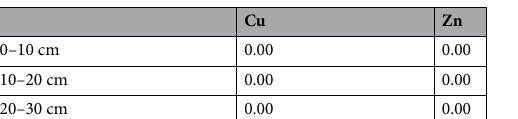
Table 2. Significance of the difference in the amount of Cu and Zn adsorbed by sediments in the direction of water flow (between